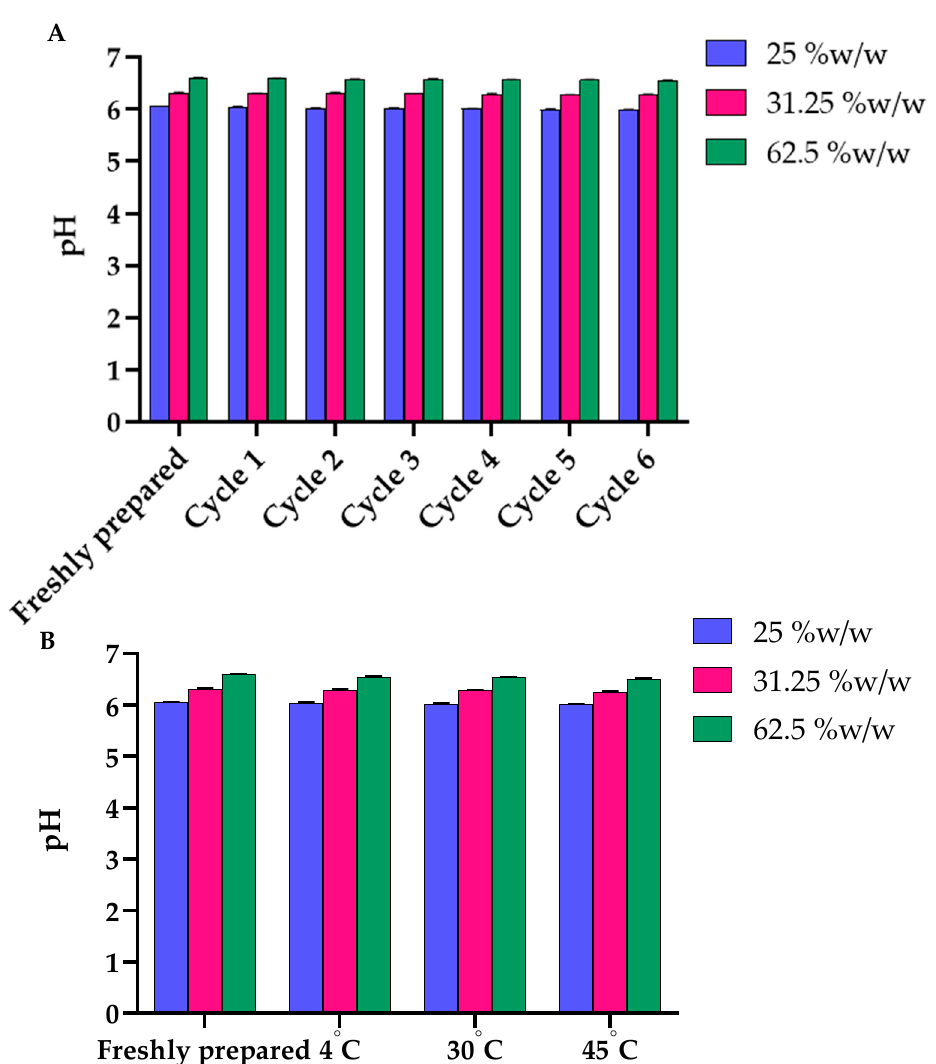
Figure 10. ( A ) Effects of six heating–cooling cycles on the pH of gel containing 25, 31.25 and 62.5% w/w of B. flabellifer male flower ethanolic extract. ( B ) Effect of temperature on the pH of gel containing 25, 31.25 and 62.5% w/w of B. flabellifer male flower ethanolic extract after storage at 4, 30 and 45 °C for 1 month.